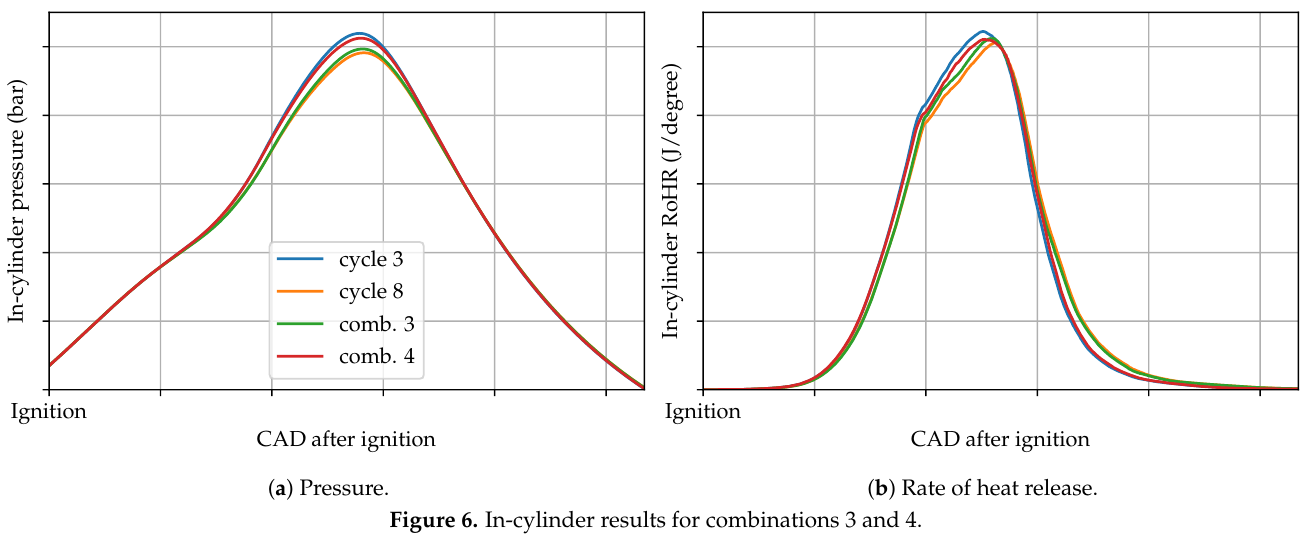
Figure 6. In-cylinder results for combinations 3 and